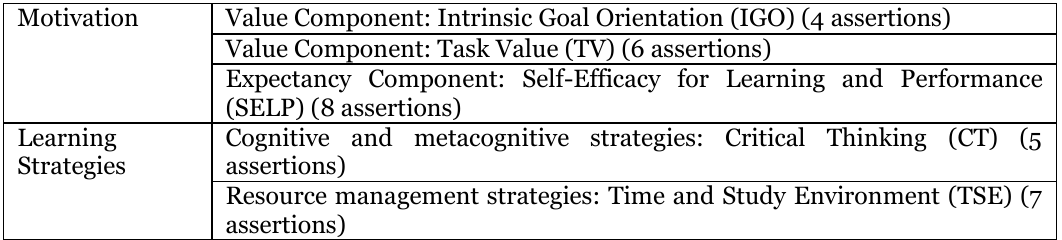
Categories of MSLQ Included in the